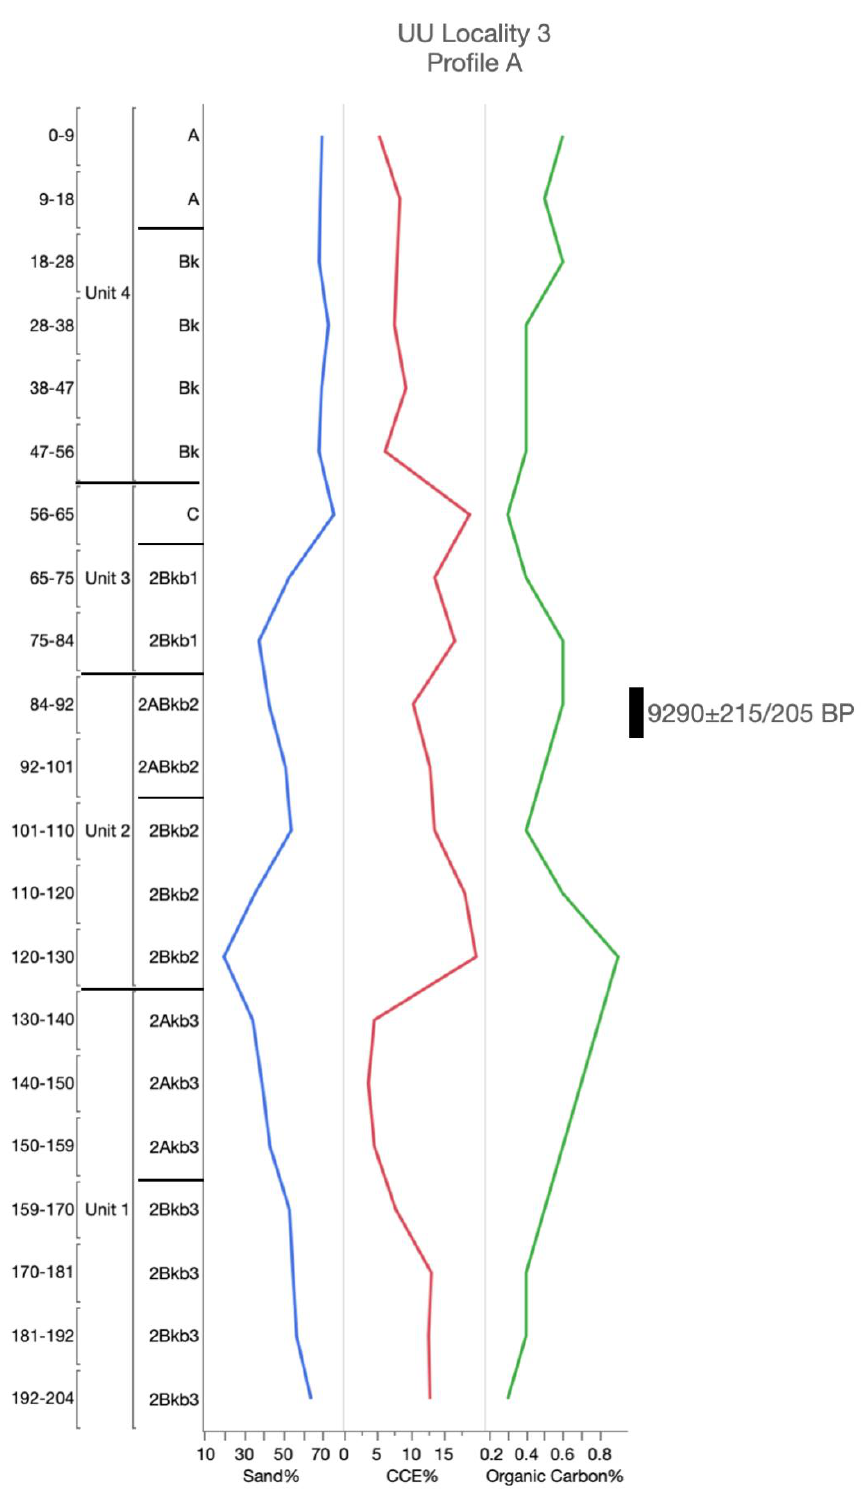
Figure A1. Accepted radiocarbon ages and soil and sediment analysis at UU Locality 3, Profile A—Post research area, northwest, Texas. CCE = calcium carbonate equivalence.